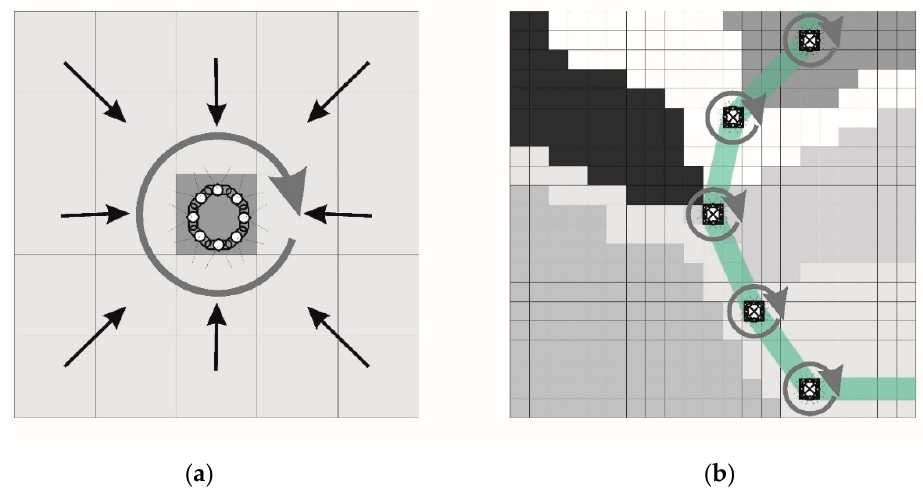
Figure 10. The principal scheme of validating the output GIS map of the spatial variation of the ǣ values in the target territory by a group of observers: ( a ) The short ‐ range viewshed observation and validation point; ( b ) The part of the hiking route with the series of the short ‐ range viewshed observation and validation points. (Drawn by Arvydas Urbis).